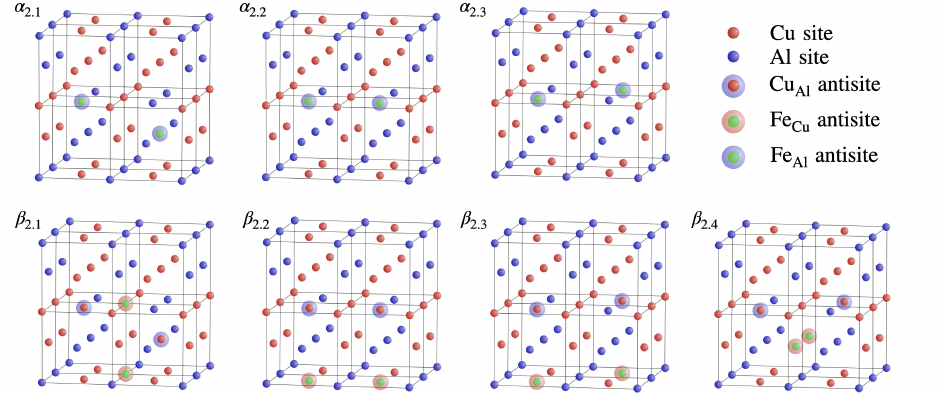
Figure 1. Illustrations showing the configurations α 2.1 , α 2.2 , α 2.3 , β 2.1 , β 2.2 , β 2.3 and β 2.4 .